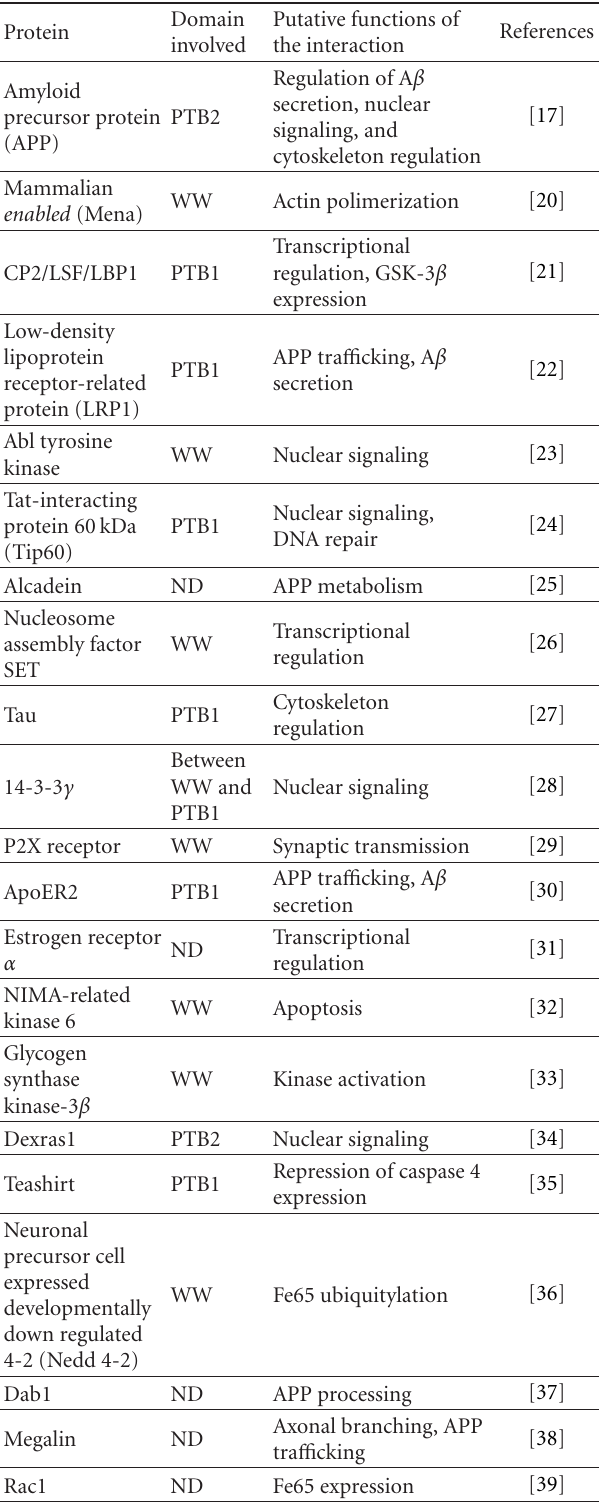
Table 1: Fe65 interactors and its